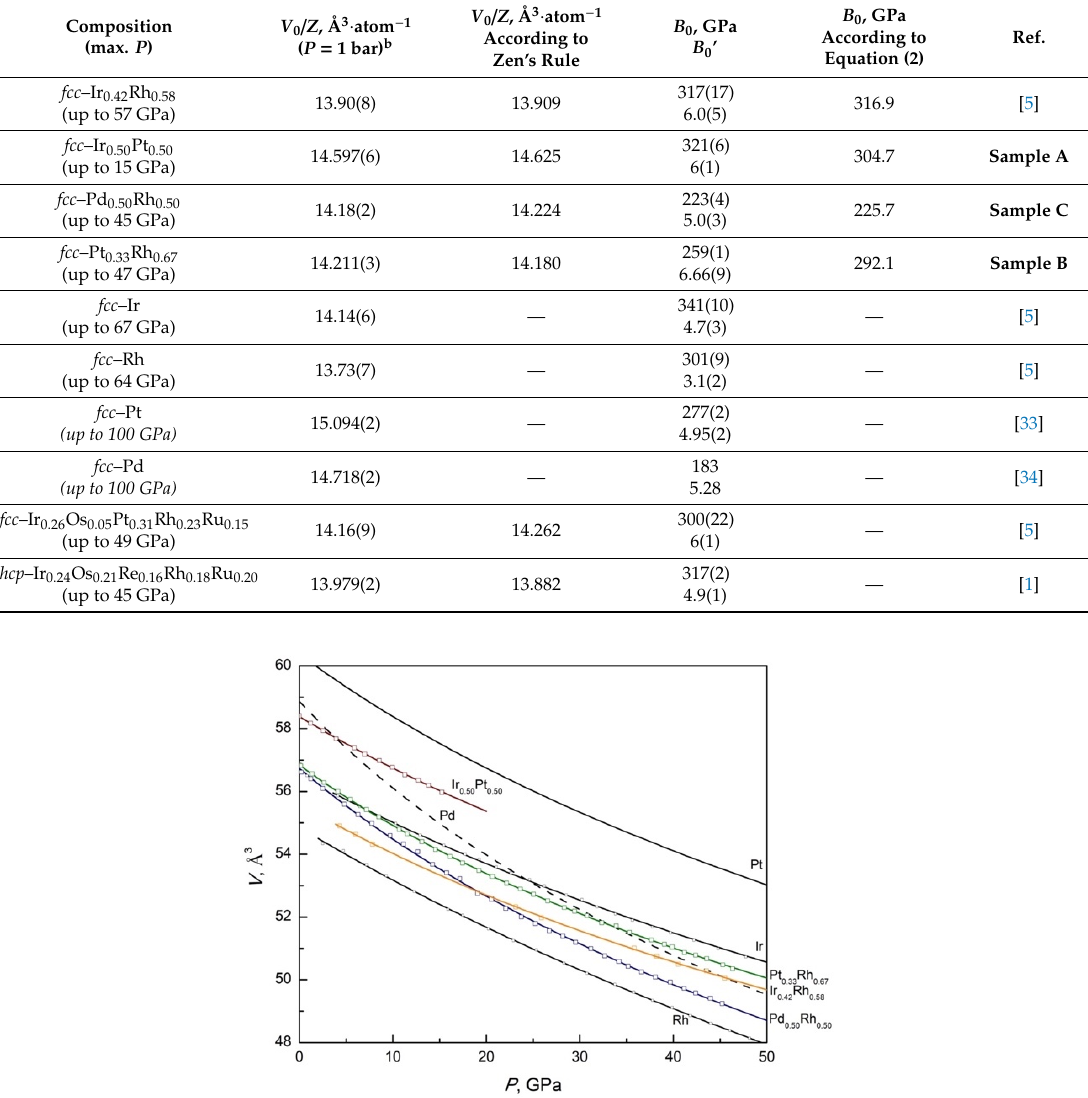
Table 3. Parameters of the equations of state (EOS) for fcc -structured Ir, Rh, Pt and Pd binary alloys and their high-entropy alloys.